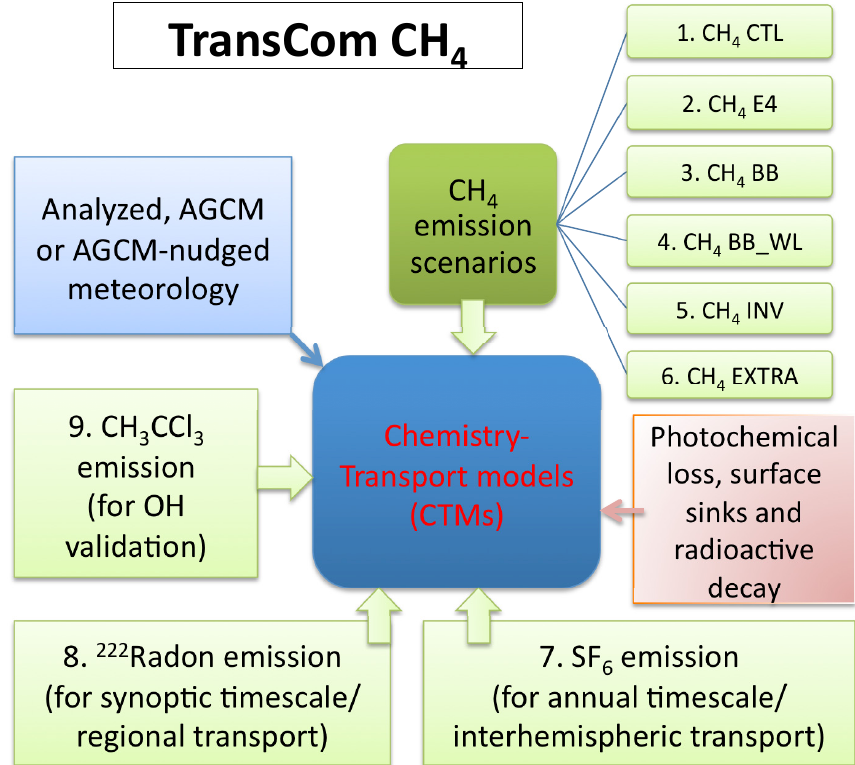
Fig. 1. Schematic diagram of TransCom-CH 4 model simulation